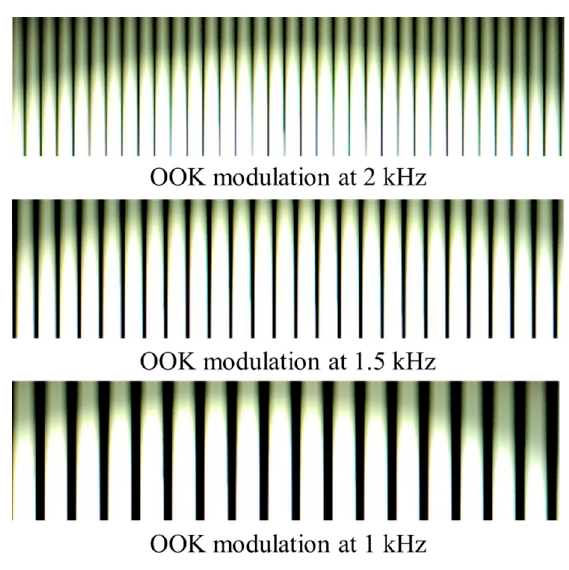
Figure 21. Captured frames of OOK modulation with different frequencies.